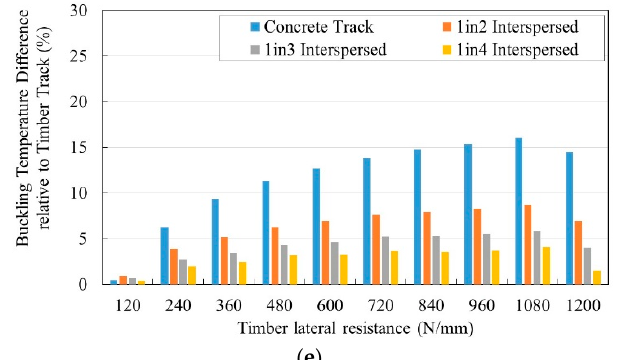
Figure 9. Buckling temperature difference relative to timber track: ( a ) Nominal torsional resistance value; ( b ) 50% reduction of nominal torsional resistance value; ( c ) 25% reduction of nominal torsional resistance value; ( d ) 25% increase of nominal torsional resistance value; ( e ) 50% increase of nominal torsional resistance value.